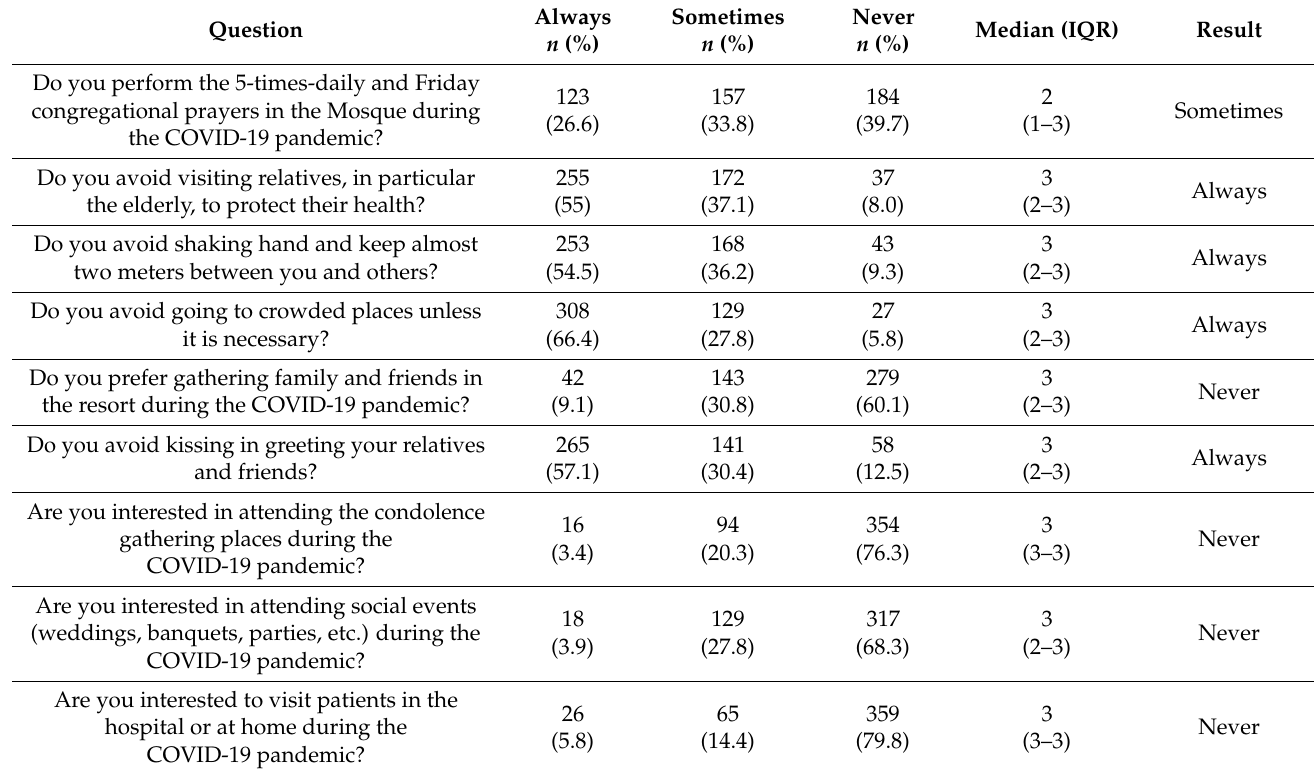
Table 3. The proportion of different social and Islamic practices toward COVID-19 among study population in